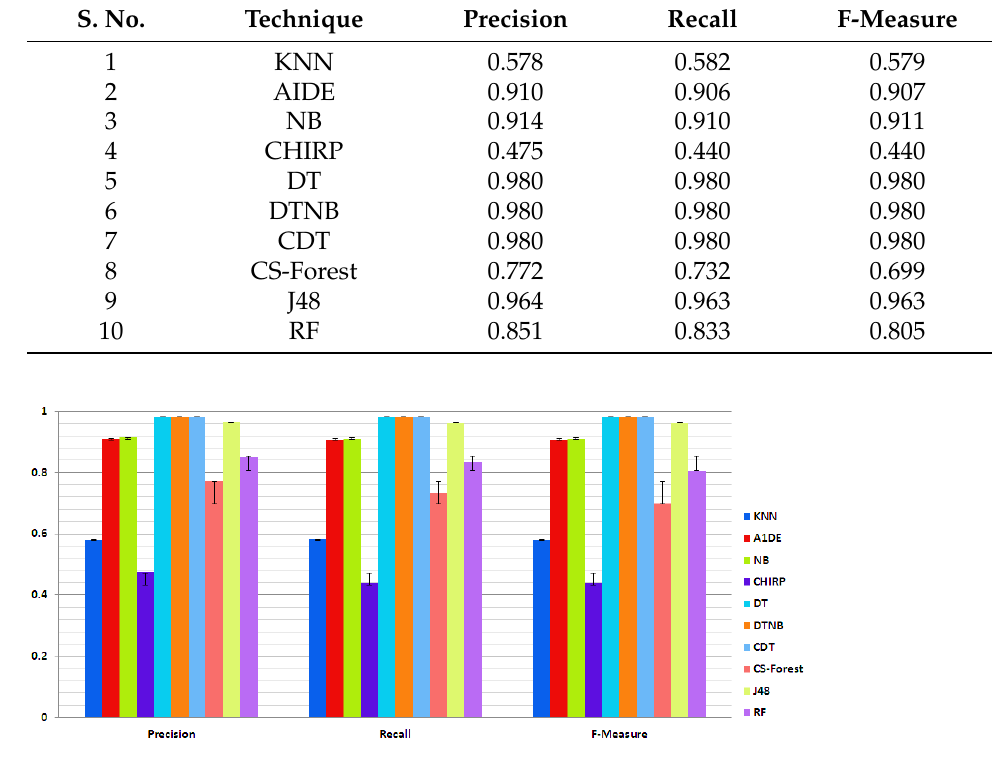
Figure 5. Precision, Recall and F-Measure analysis of individual technique along with SD